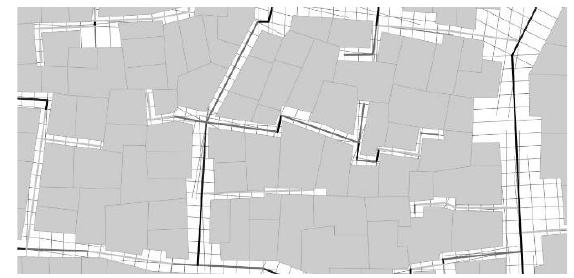
Figure 5. Measurement of existing road width.